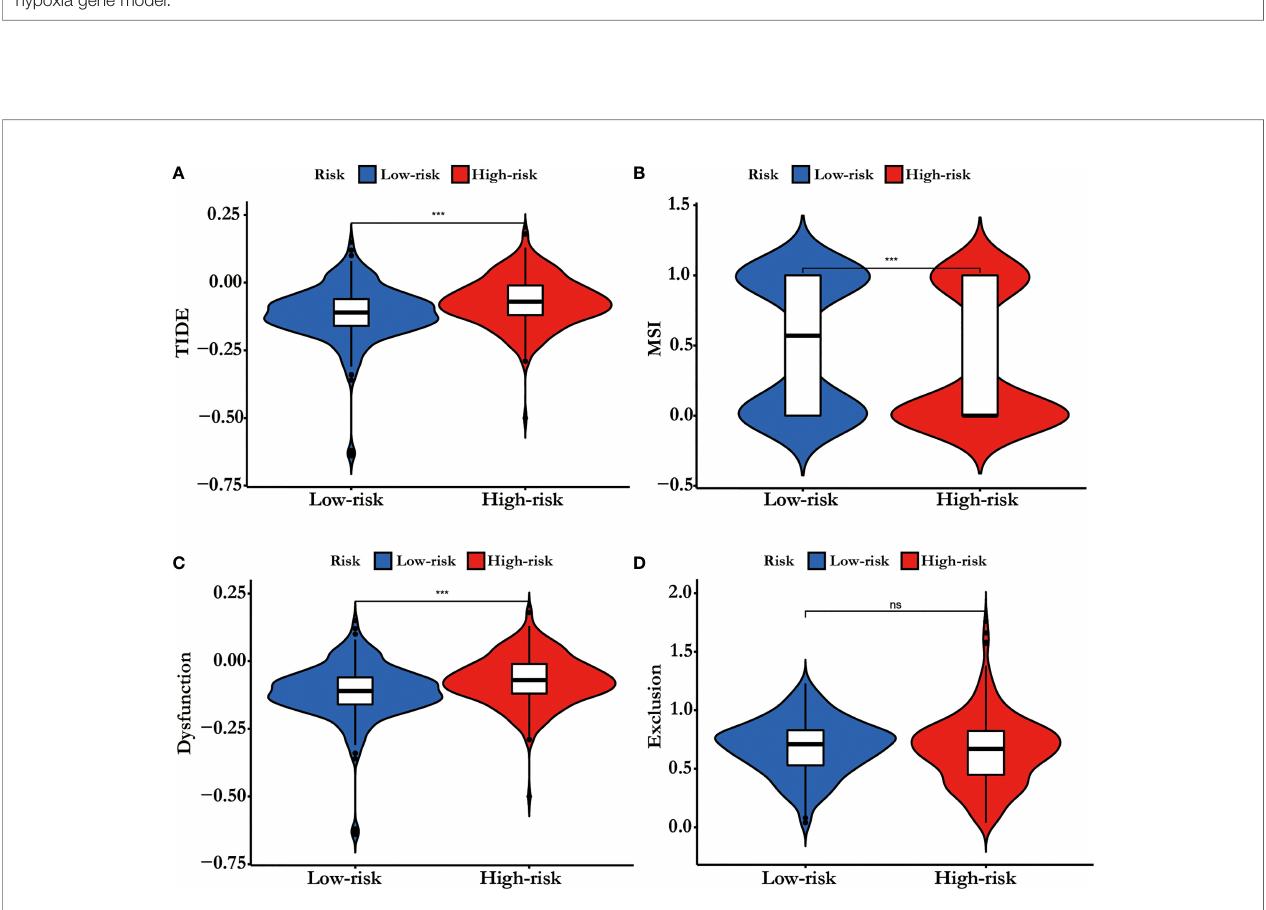
FIGURE 7 | (A) TIDE score, (B) MSI, (C) T cell Dysfunction and (D) Exclusion in different risk-groups. The score between the two risk-groups were compared through Wilcoxon test (ns, not signi fi cant, ***p <